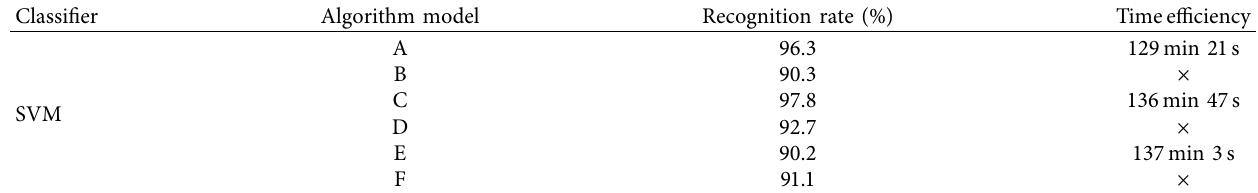
Table 2: Recognition rate and time efficiency.